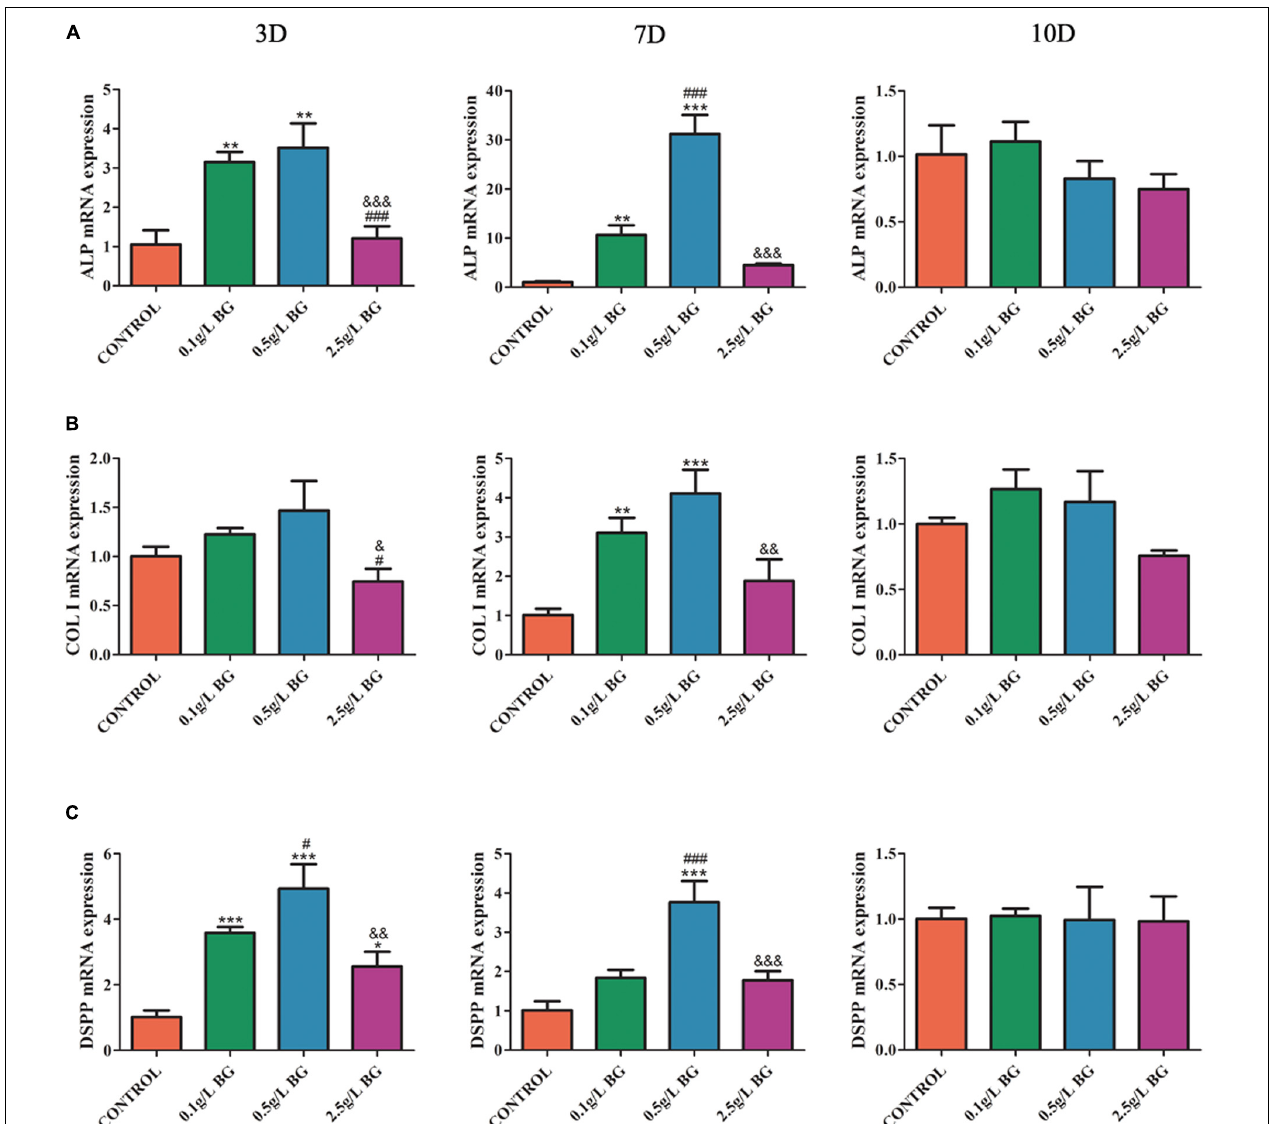
FIGURE 4 | Odontogenic gene expression analysis. (A) ALP, (B) COLI, and (C) DSPP at days 3, 7, and 10. The data are presented as mean ± SD from 3 independent experiments ( n = 3). Significant effect of treatment: compared to control, * P < 0.05, ** P < 0.01, *** P < 0.001; compared to 0.1 g/L-group, # P < 0.05, ### P < 0.001; compared to 0.5 g/L-group, & P < 0.05, && P < 0.01, &&& P < 0.001. D: